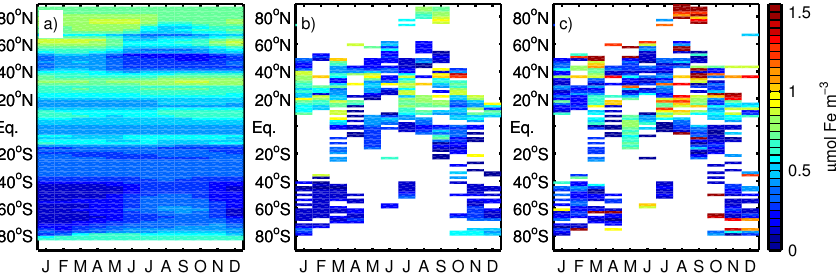
Figure 7. Zonal mean iron concentrations at the ocean surface plotted over time (Hovmöller diagram) as simulated with the model (a) , model results averaged only at the locations of the observations (Tagliabue et al., 2012) (b) and the observations (c) .